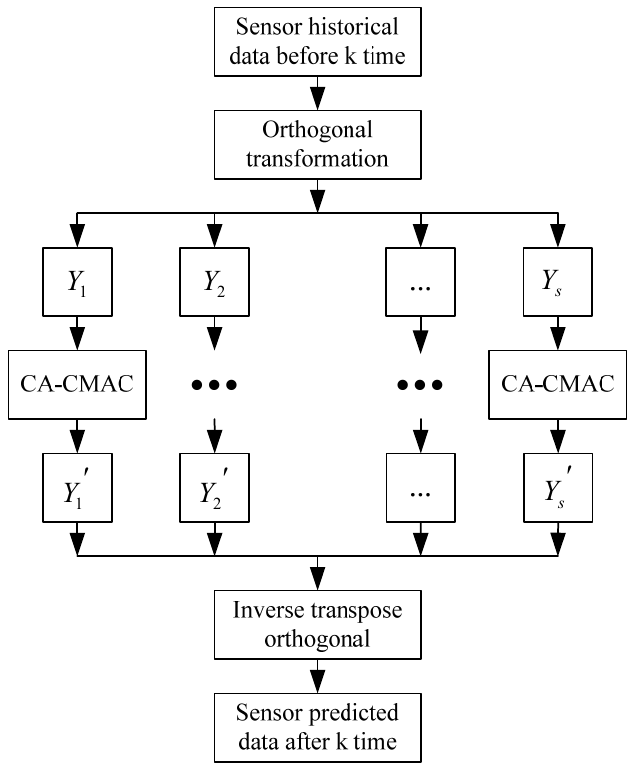
Figure 2. Signal forecasting model based on